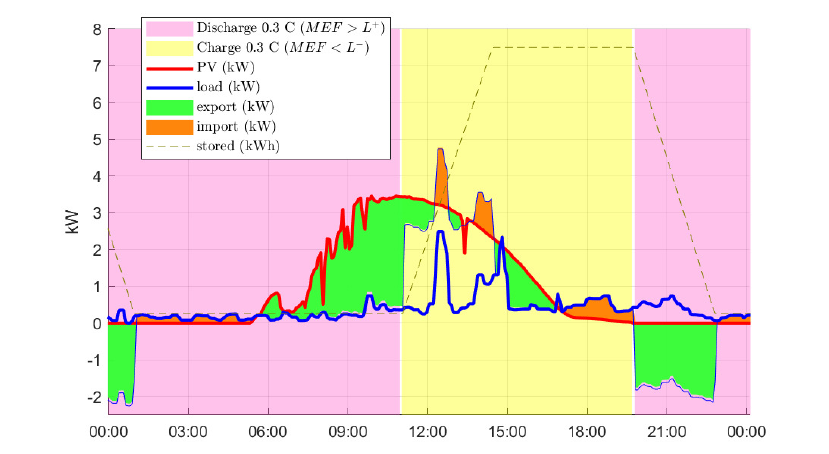
Figure 2. Operation of the emissions arbitrage algorithm for scenario CR50 (Section 3.4) with 4 kW